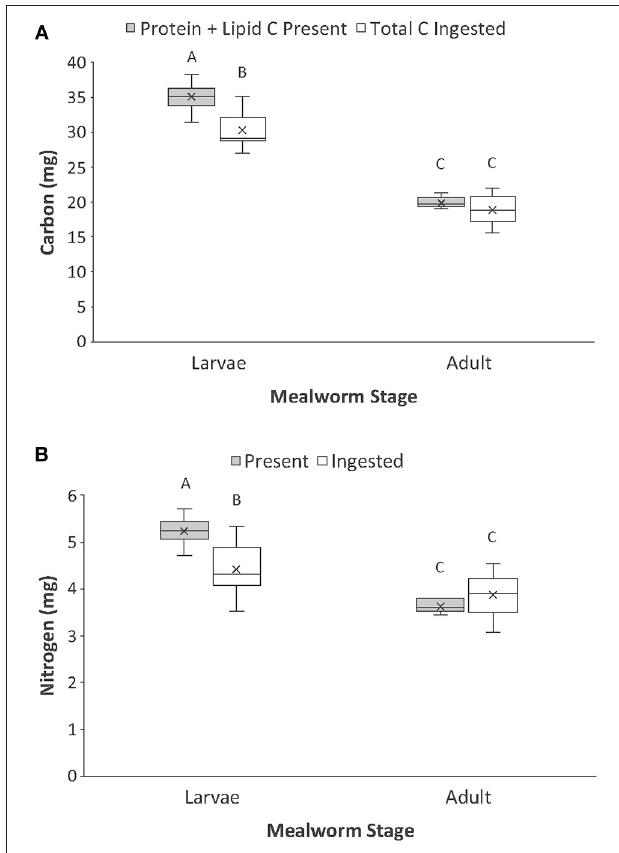
FIGURE 4 | Comparison of the (A) carbon present in lipid and protein of whole prey (i.e., macronutrient-based C) vs. total carbon ingested, and (B) nitrogen present in protein of whole prey (i.e., macronutrient-based N) vs. total nitrogen ingested by spiders when feeding on larval and adult mealworm beetles. Boxplots display the interquartile range (the box), median (line in the box), mean (x in the box), minimum (lower whisker), maximum (upper whisker), and any outliers (additional points). Treatments with different letters are significantly different from each other in post hoc